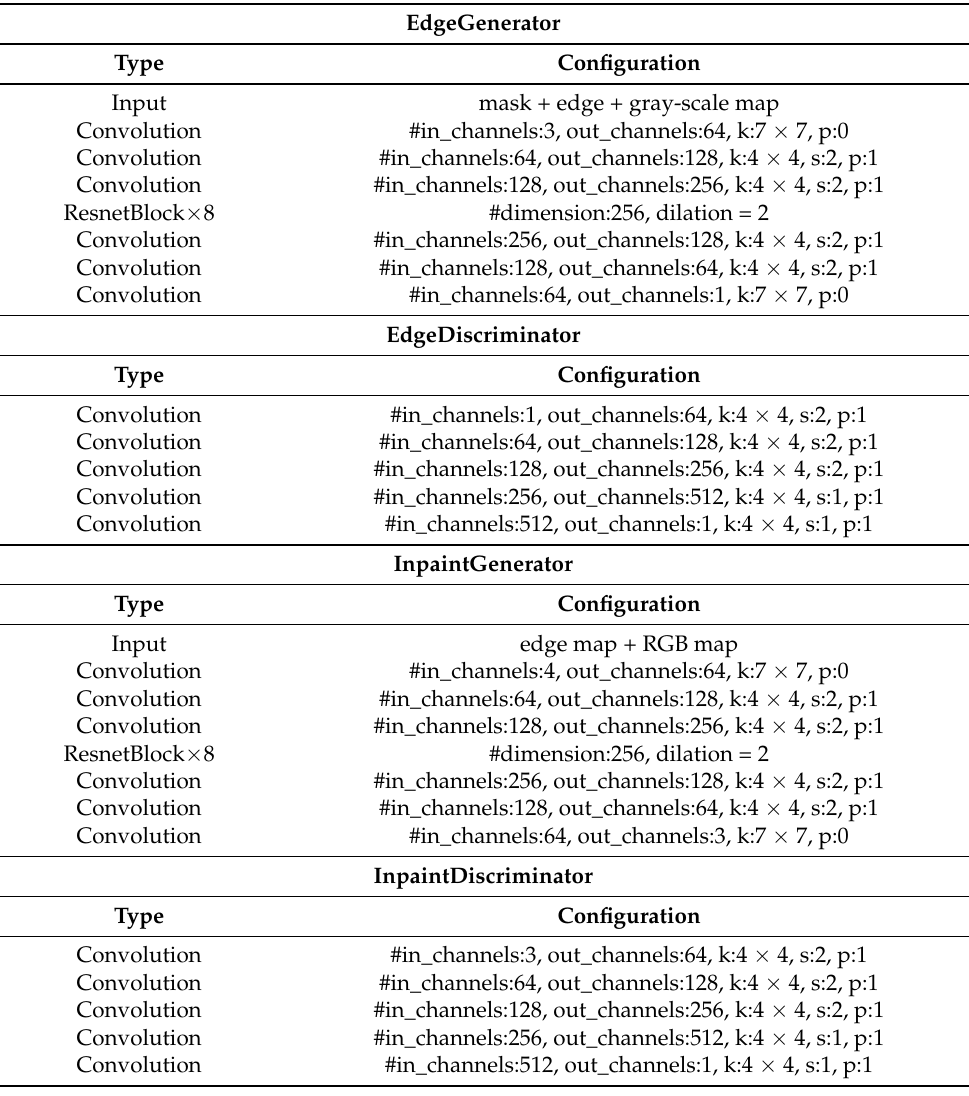
Table A3. Network configuration summary of EdgeConnect. ‘k’, ‘s’, and ‘p’ stand for the kernel size, stride size, and padding size,